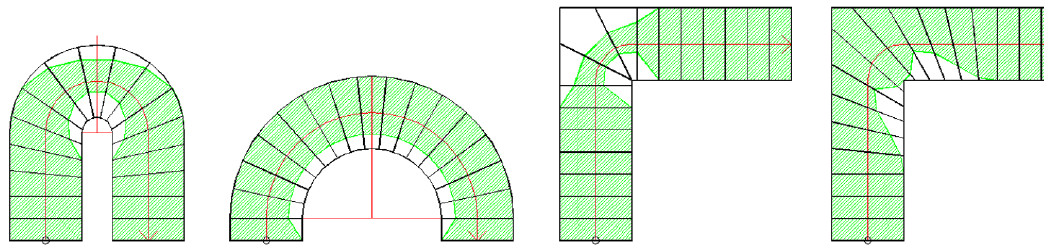
Fig. 2. Climbing lane width of a different forms of